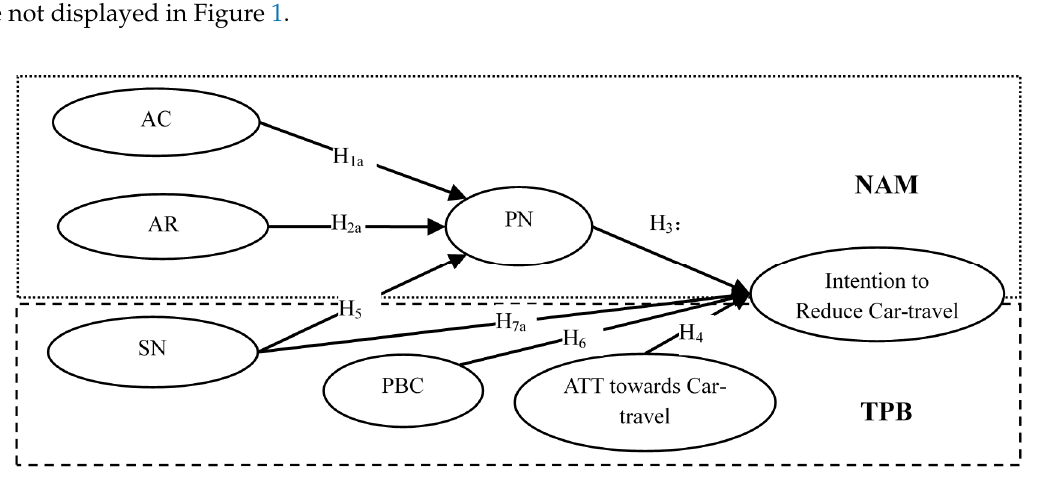
Figure 1. Conceptual Framework. Note: AC = Awareness of consequence of car-travel; AR = Ascription of responsibility for car-travel reduction; PN = Personal norm of car-travel reduction; SN = Subjective norm of car-travel reduction; PBC = PBC over car-travel reduction.